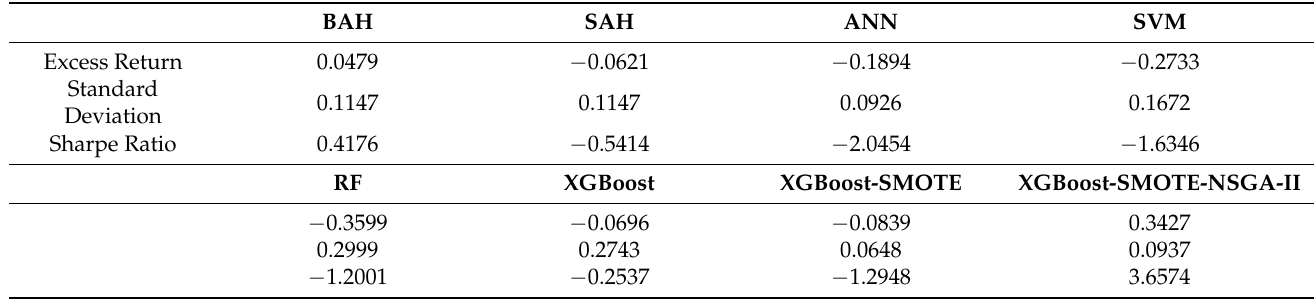
Table 9. Sharpe ratio results of all methods for simulation